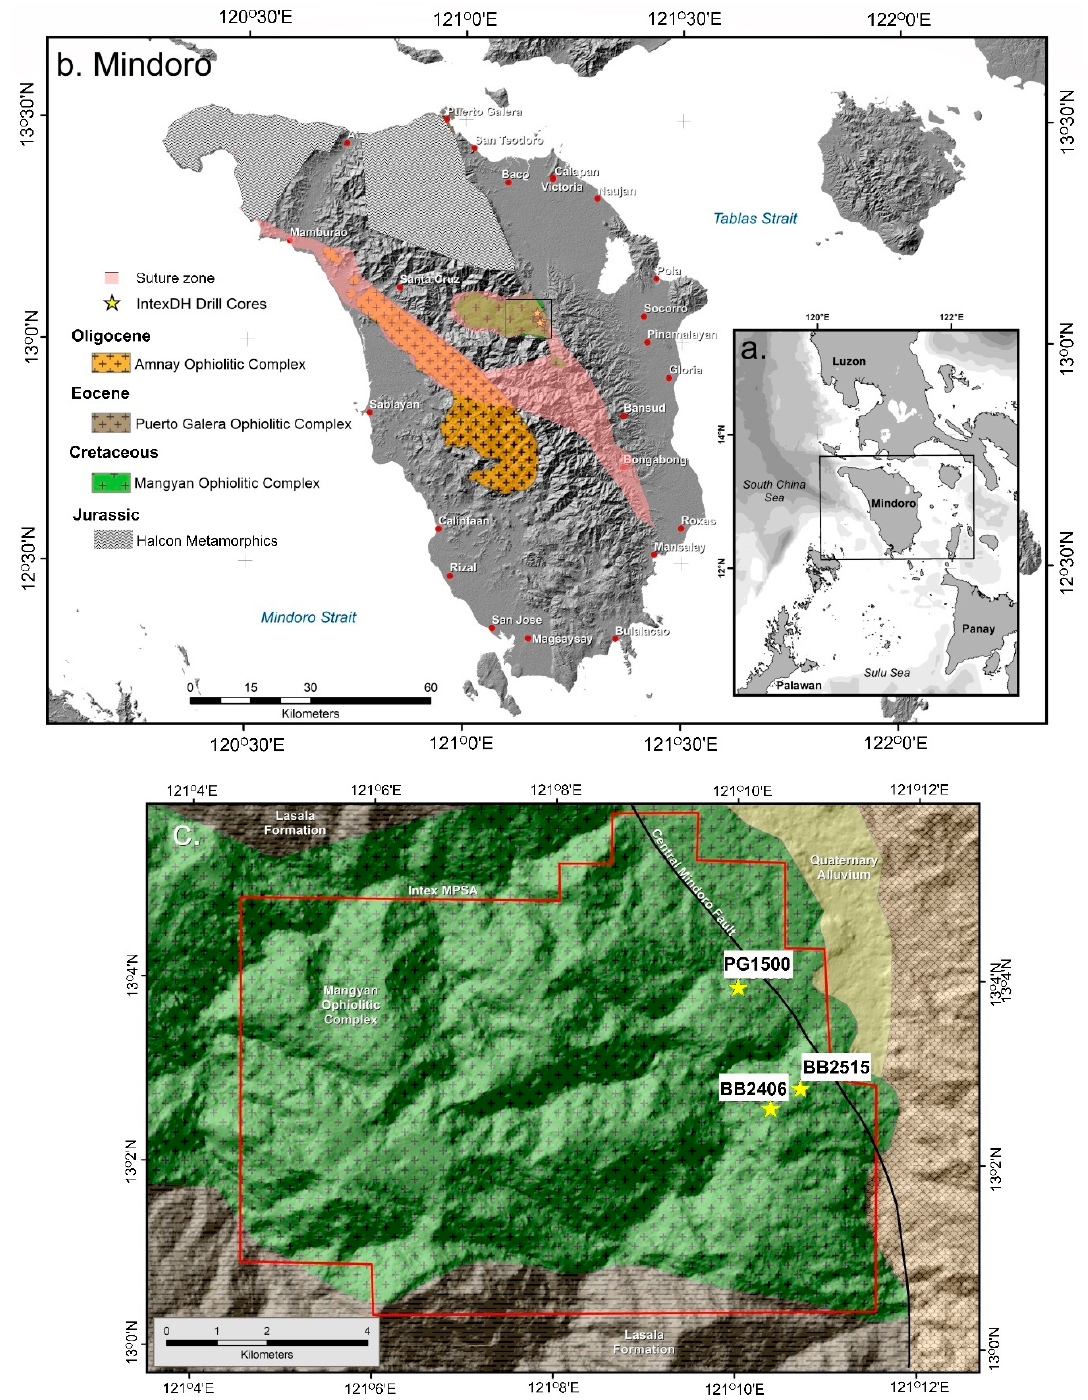
Figure 1. Location map of ( a ) Mindoro ( b ) ophiolitic complexes on the island and ( c ) studied drill cores.